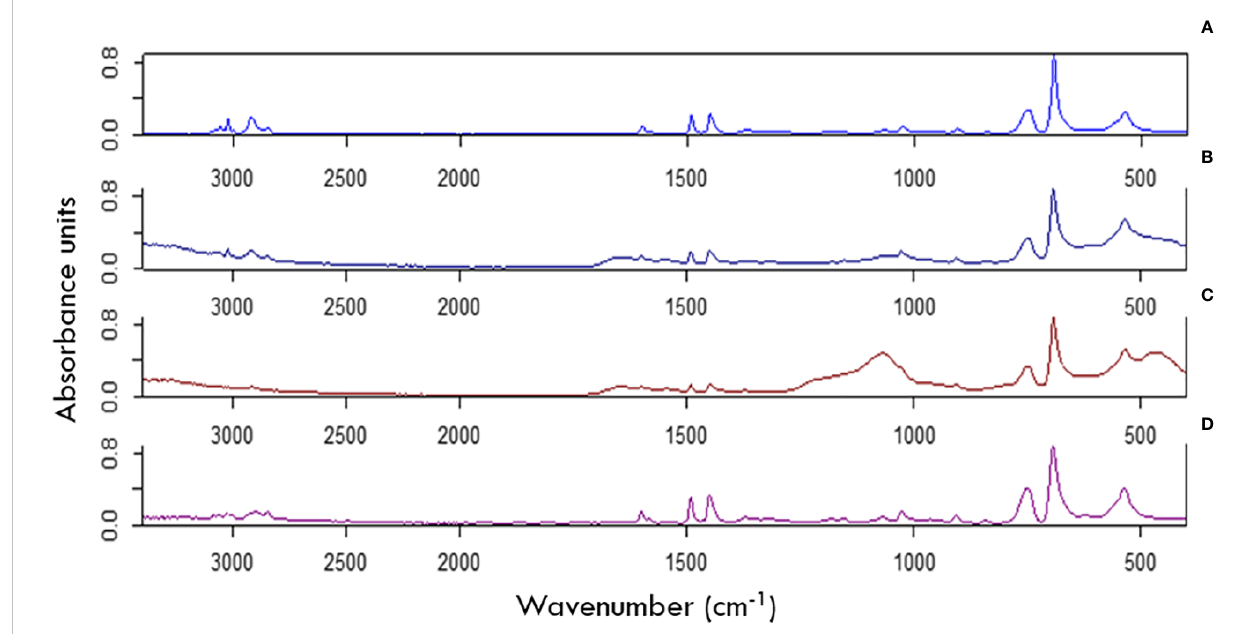
FIGURE 5 FTIR spectra of pristine (not exposed) PS and PS exposed for 12 months in metal cups and stakes. (A) Not exposed PS sheet showing no oxidation. (B) PS exposed to the surface water compartment for one year, shows some oxidation in the ranges of 1600-500cm -1 . (C) PS exposed to the top sediment compartment for one year shows extensive oxidation on the FTIR spectra in the ranges of 1600-500cm -1 . (D) PS exposed to the bottom sediment for one year shows no oxidation in the ranges of 1600-500cm -1 but limited changes in absorbance in the ranges between 2700 and 3100 cm -1